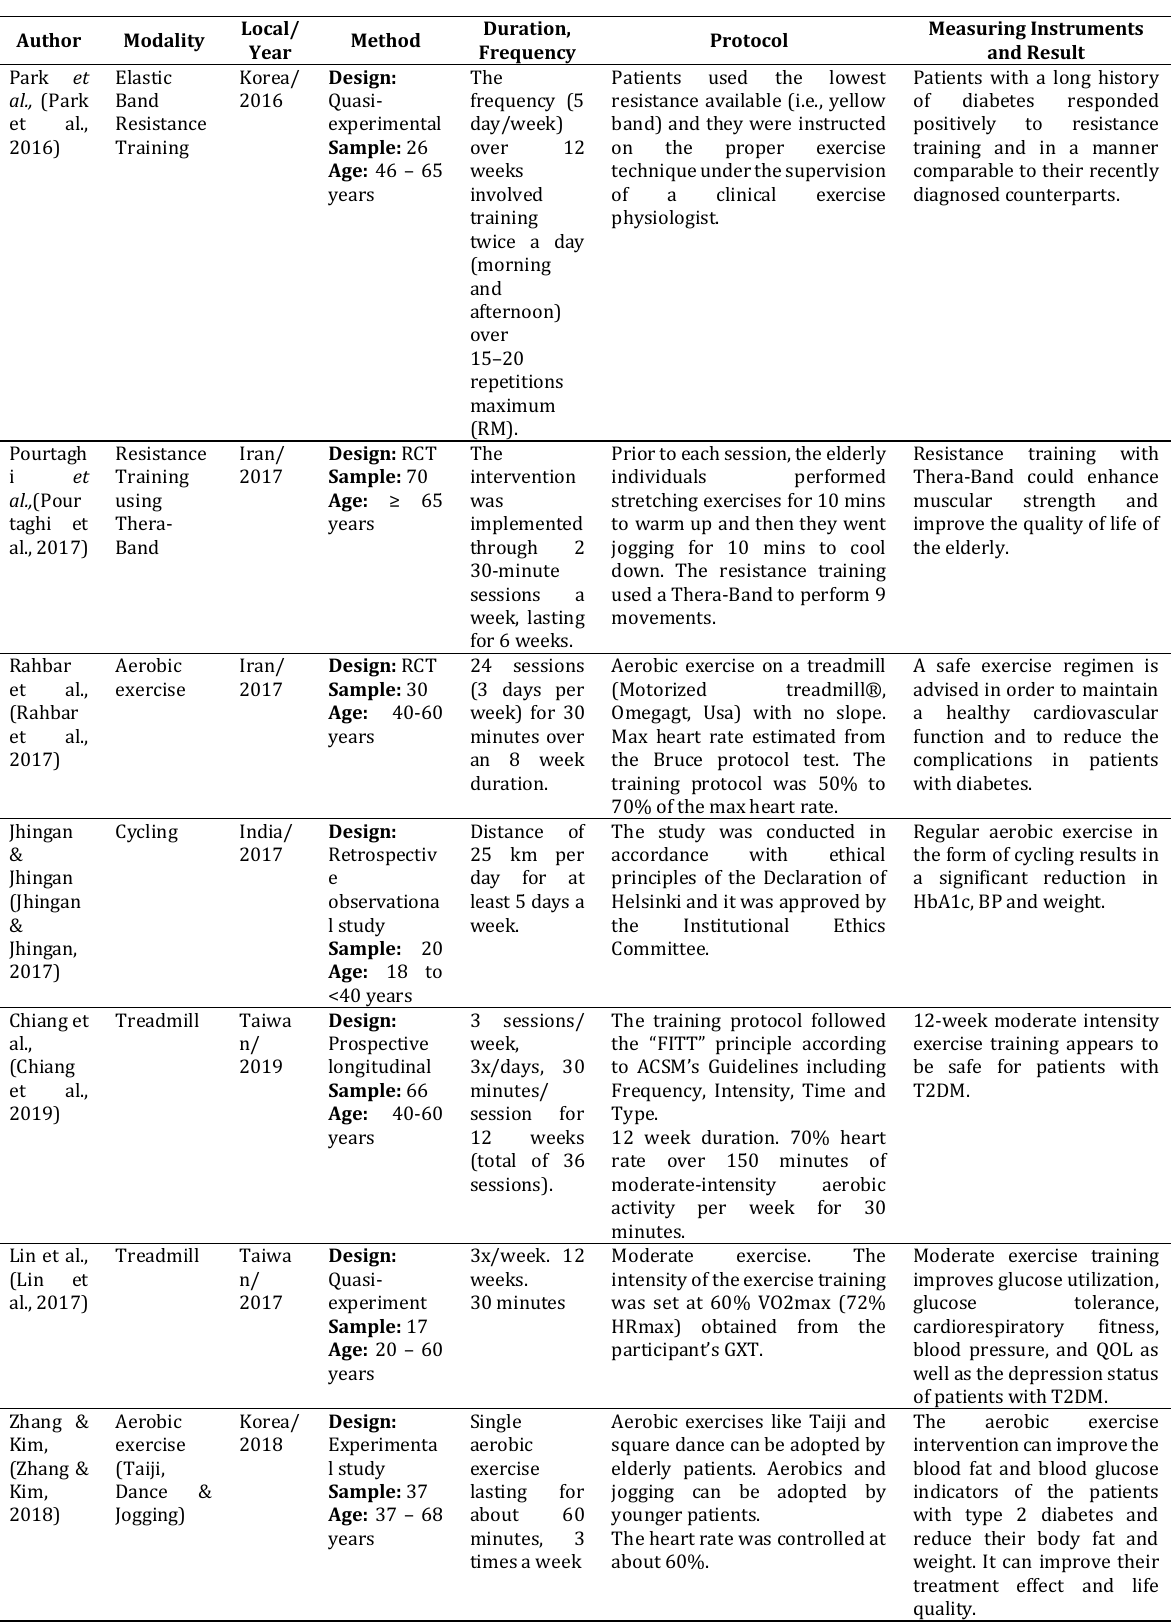
Table 2. Detailed Intervention Programs in the